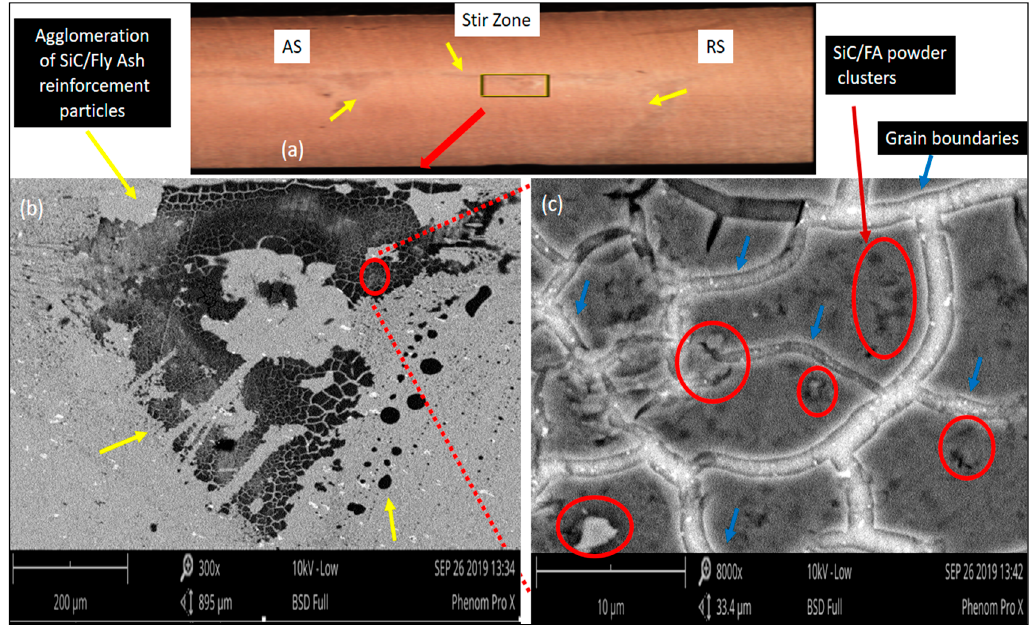
Figure 3. The SEM micrographs of Run 9 AA7075-SiC/FA composite showing ( a ) stir zone cross-sectional view ( b ) (300× magnification) agglomeration of FA/SiC particles in the stir zone area ( c ) (high magnification 8000×) clusters of FA/SiC particles interlocked and agglomerated region separation grain boundaries.